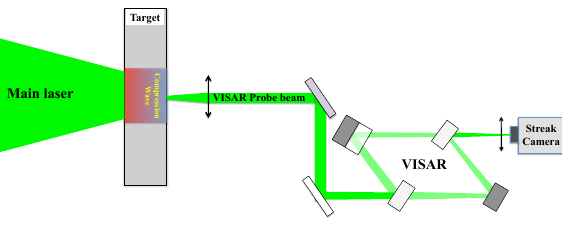
Figure 2. Schematic experimental set up where a Velocity Interferometer System for Any Reflector (VISAR) was used to record the target free